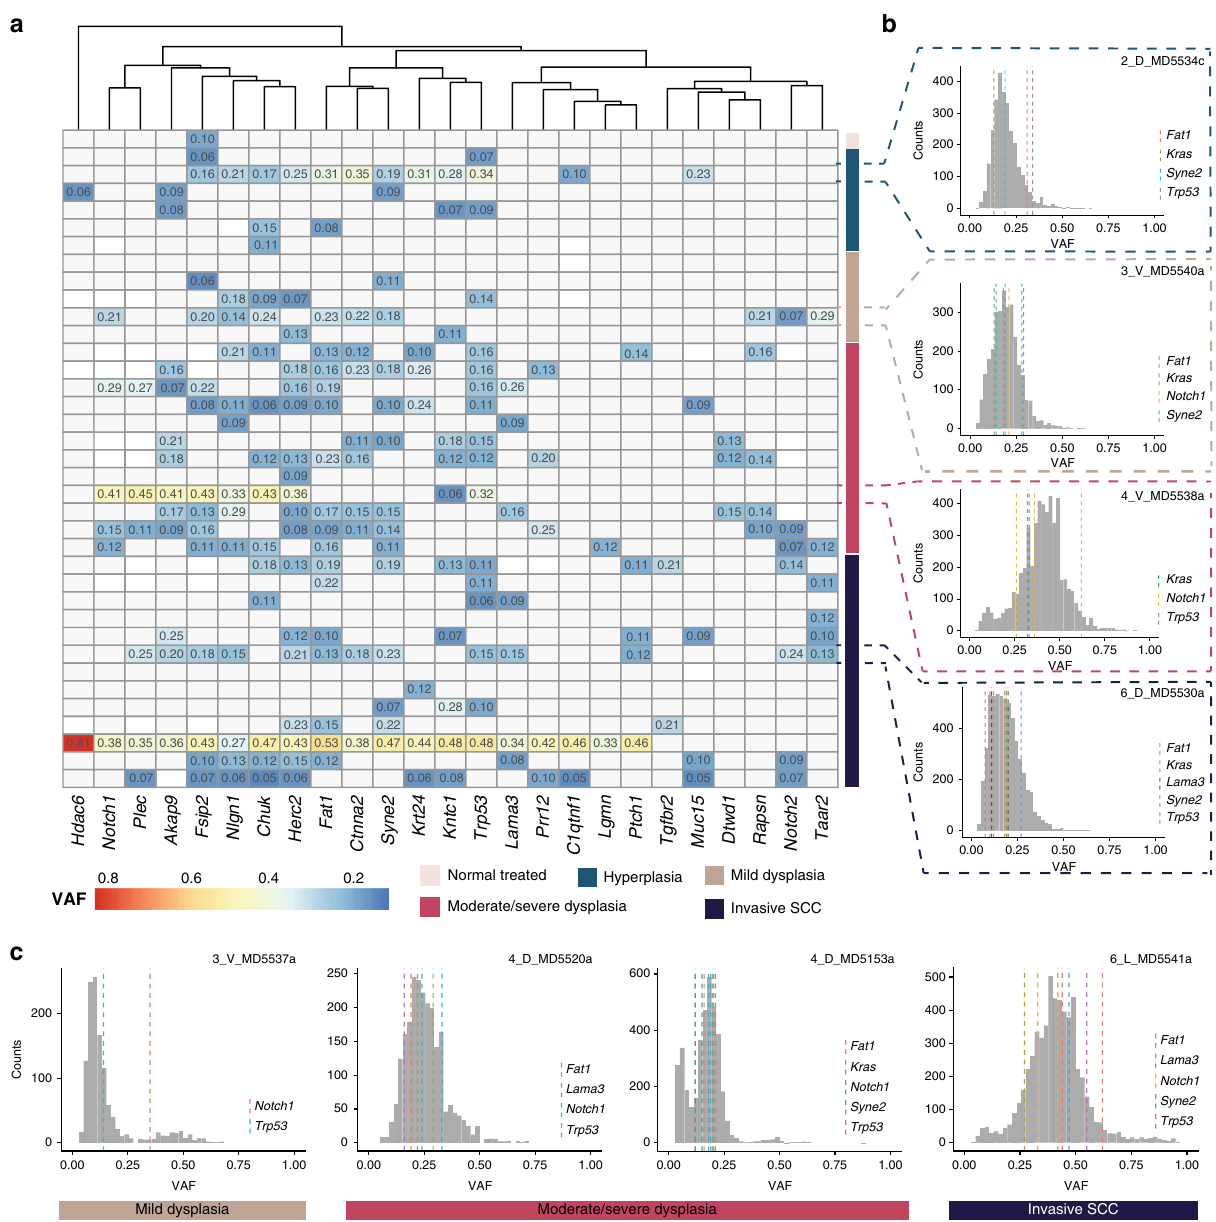
Fig. 6 Tumour clonality. a Heatmap showing the average VAF value of mutations of each gene (columns) in the samples where at least one mutation was detected (rows). The genes are ordered according to hierarchical clustering, and samples are ordered according to diagnosis (see colour code). b For each diagnosis, the distribution of the VAF of somatic mutations in one sample is shown. Grey bars represent the number of mutations for each gene. c Representative plots of VAF distribution of somatic mutations for higher-grade samples annotated with driver mutations. Mutations with relatively high frequency ( f > 0.25) are likely to be clonal